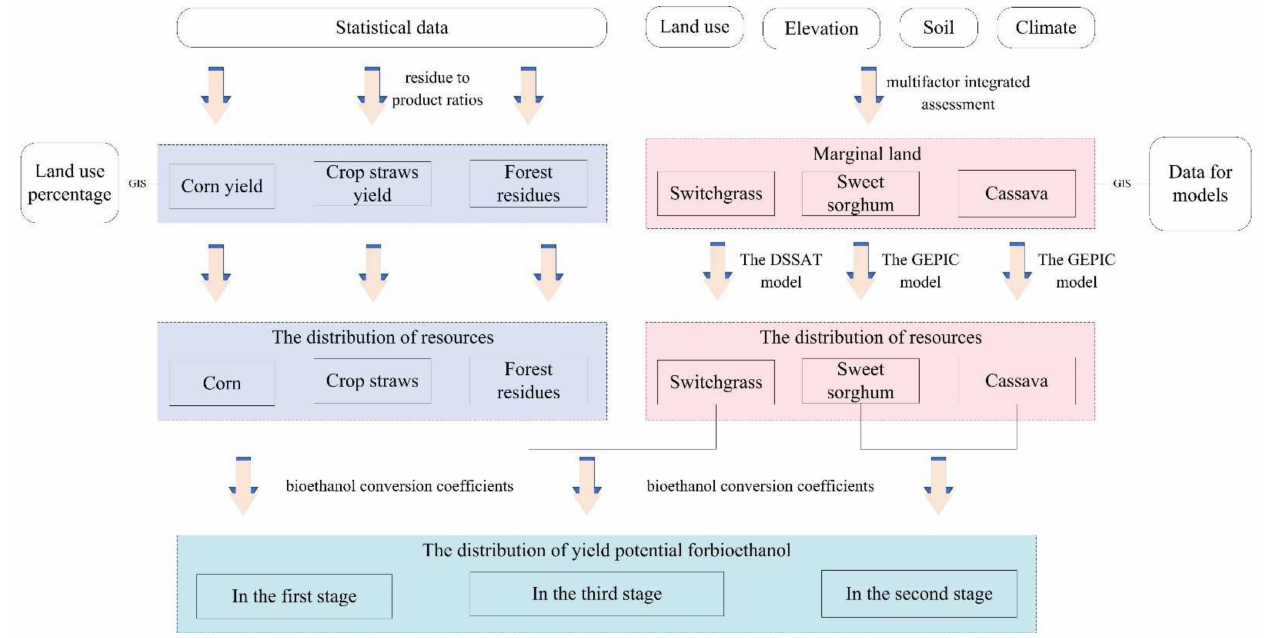
Figure 1. Technology roadmap of this